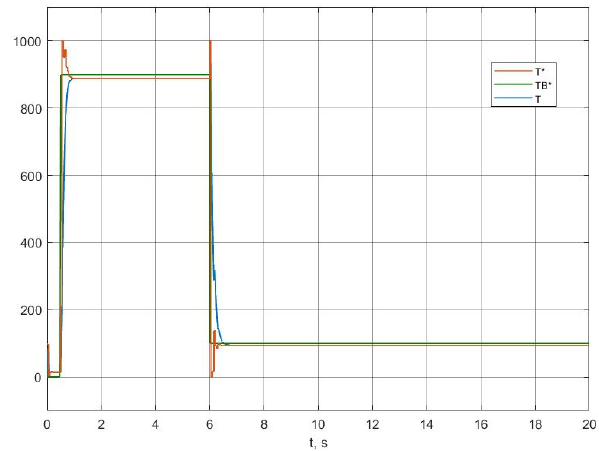
Figure 8. The responses of the MRC ( T* ) and PBEV ( T ) to the double-step driver’s reference ( TB* ).